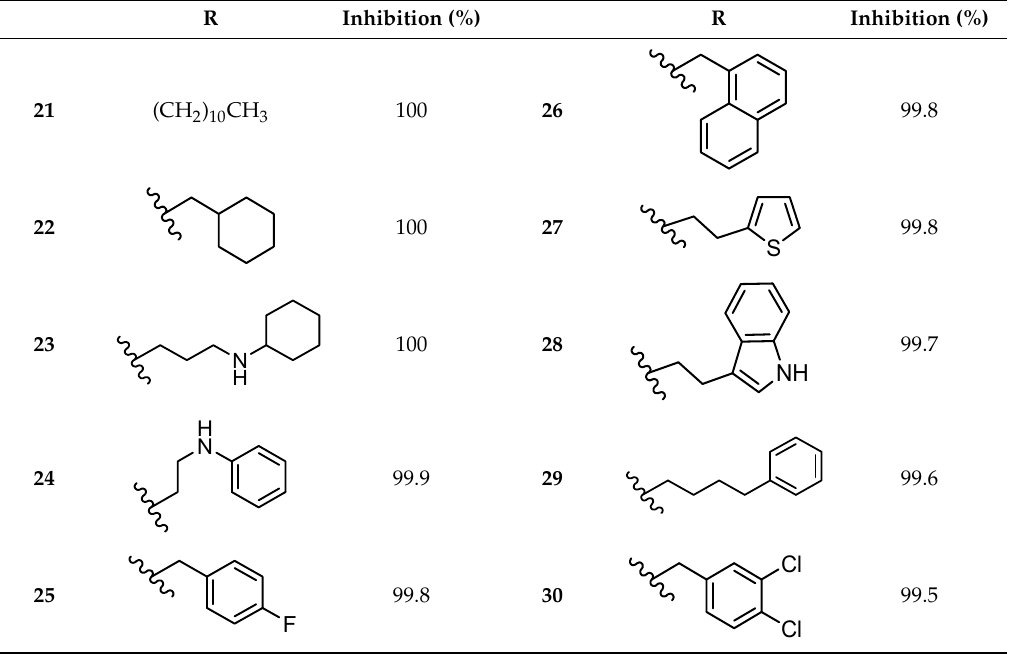
Table 3. Structural details and HCMV polymerase inhibition values of compounds 31 – 38 (adapted from [86]).